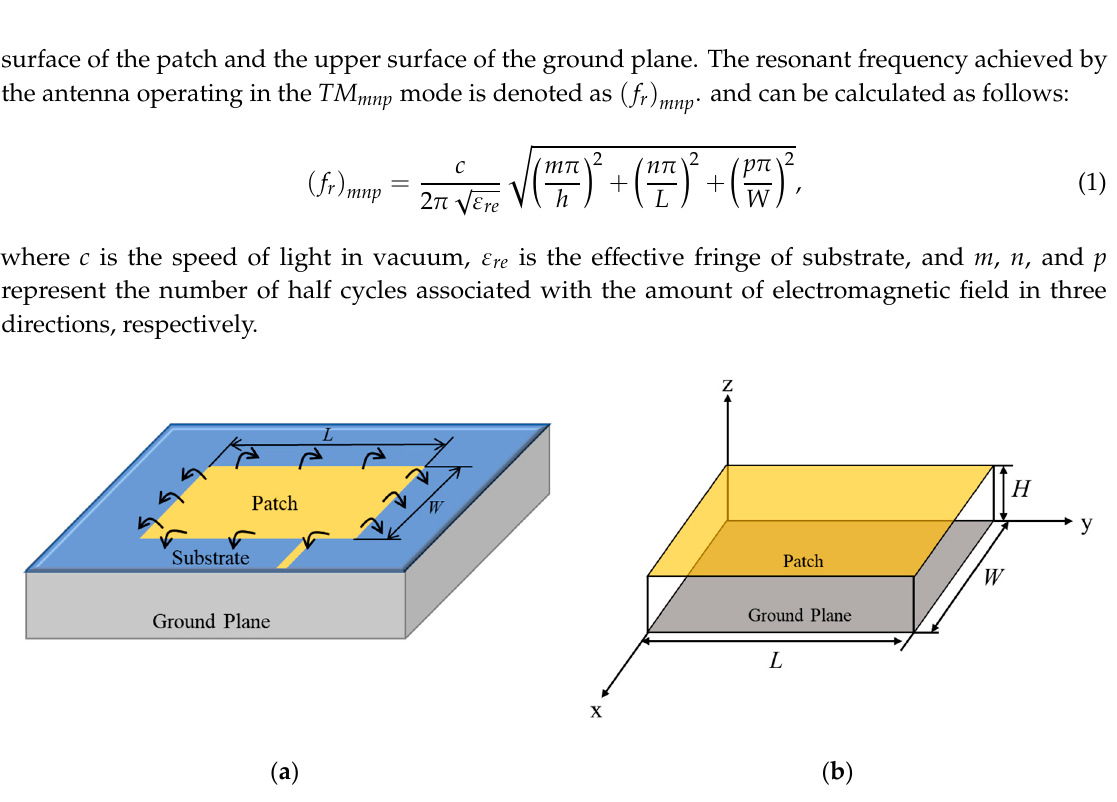
Figure 1. Crack monitoring mechanism of the patch antenna sensor. ( a ) Patch antenna senor structure and ( b ) resonant cavity model.